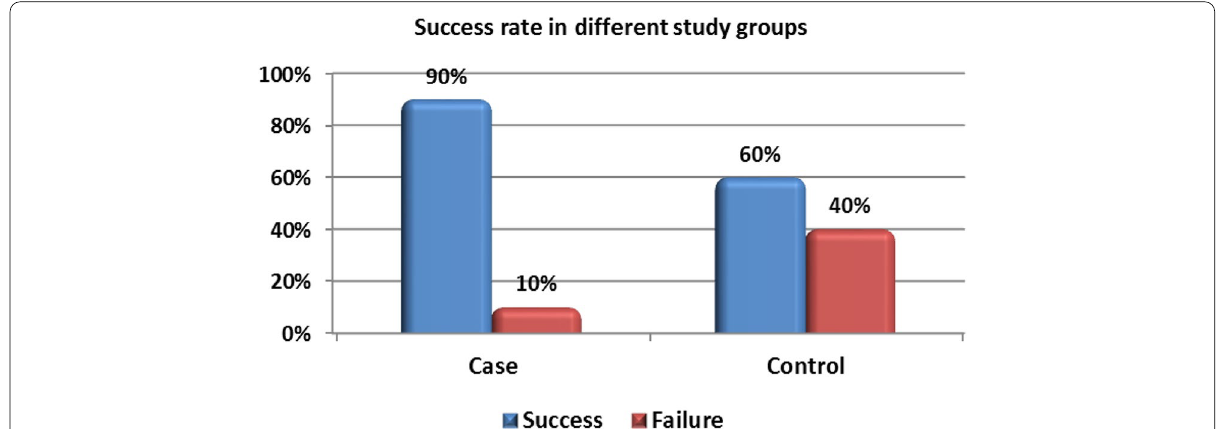
Fig. 3 Comparison between the success rates in both groups